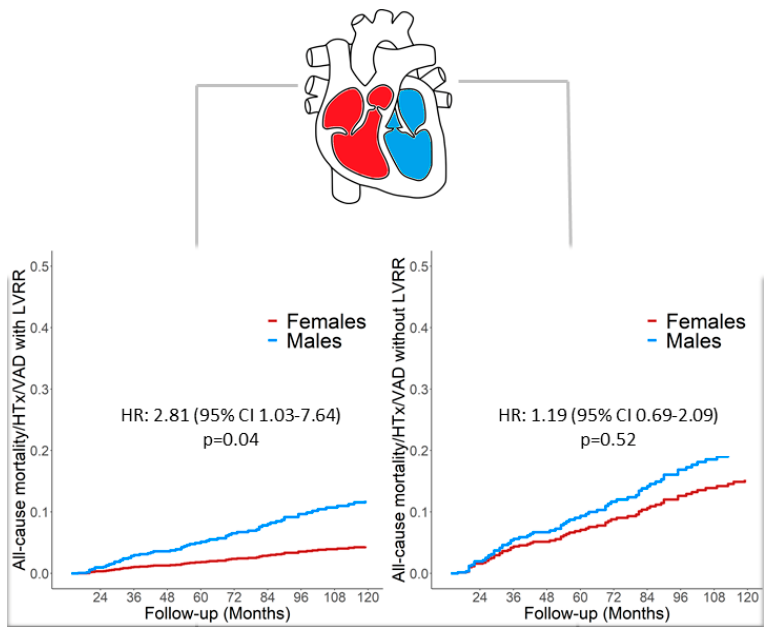
Figure 4. Central Illustration Schematic representation of the main results of the study. The rate of LVRR is comparable between sexes; however, male sex is an independent adverse prognostic factor regardless of the occurrence of LVRR. Legend: Legend. HTx: Heart Transplantation; LVRR: Left Ventricular Reverse Remodelling; VAD: Ventricular Assist Device.